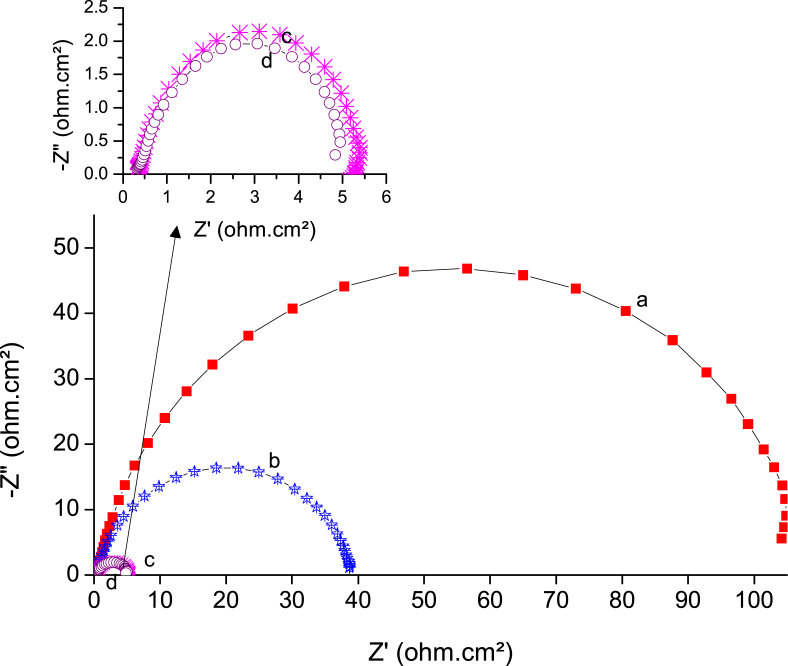
Nyquist plots for mild steel in the presence of 1 mM of BQYP molecules in 2 M H2SO4 at a) 298, b) 308, c) 318, and d) 328 °K.